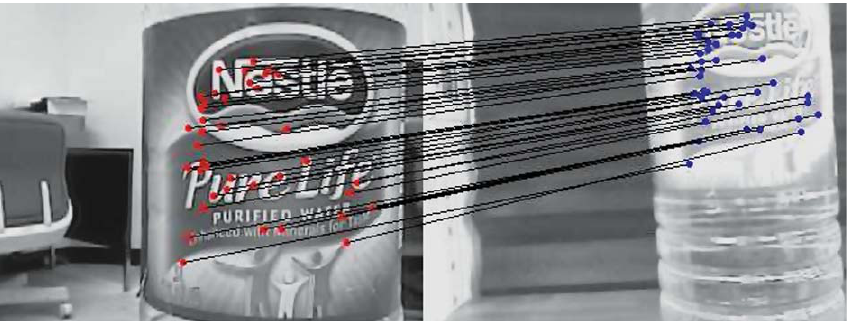
Fig. 7. Object recognition: a successful match between template (left) to current gripper camera view (right) after gross motion and visual alignment.